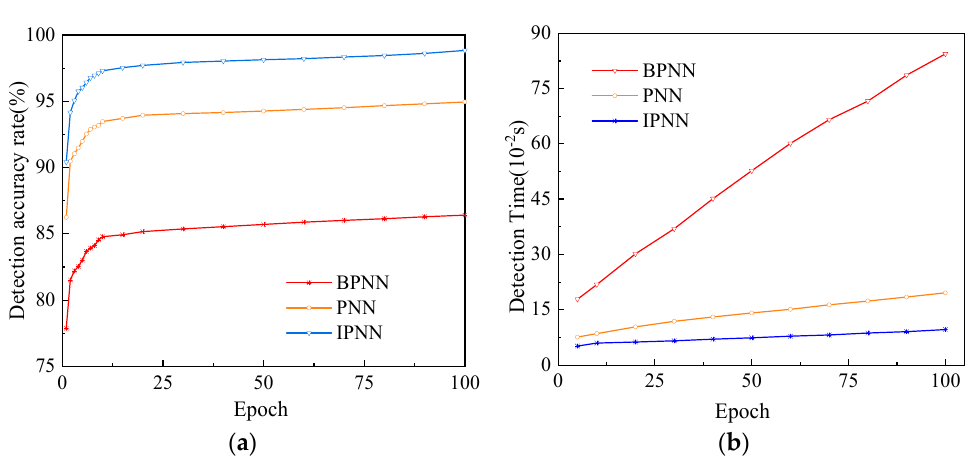
Figure 9. Detection performance change curve of three deception detection models: ( a ) Detection accuracy rate change curve of three deception detection models; ( b ) Detection time change curve of three deception detection models.